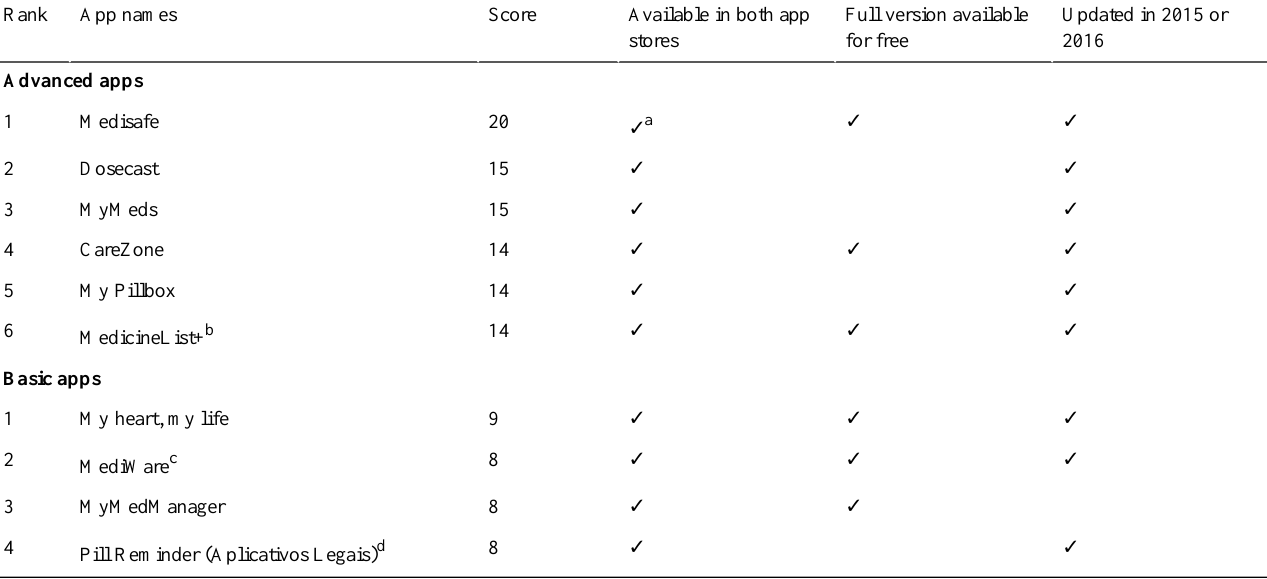
Table 2. Rank and score of and practical features present in the top advanced and basic medication reminder